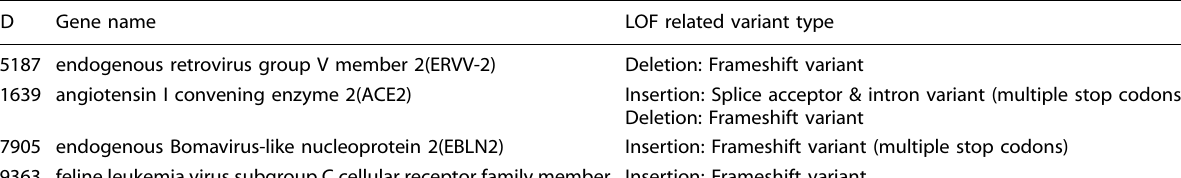
Table 2. Proviral genes which lost their function due to structural